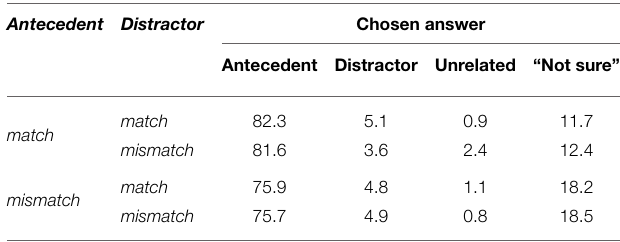
TABLE 2 | Experiment 1: Chosen answer to the comprehension question by condition in percentages. Antecedent